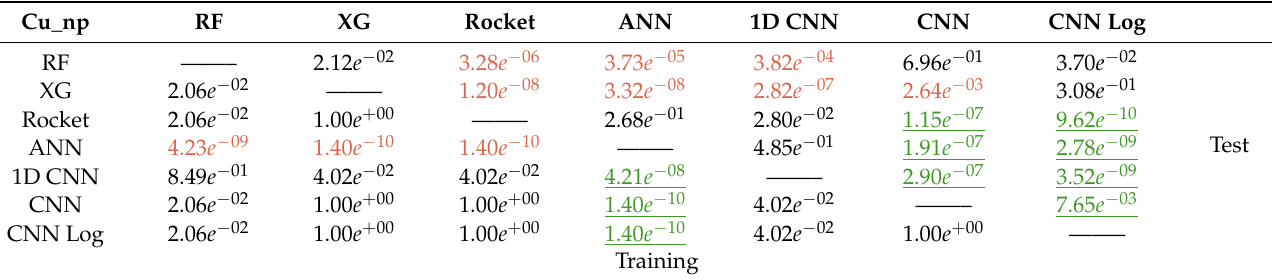
Table A10. Kruskal–Wallis p -values comparing all methods of the Cu_np concentration prediction task. Above the diagonal, we have the results for the test set, and below for the training set. Significant results ( p < 0.01) are represented in green or red when the method on the left is significantly better or worse, respectively.